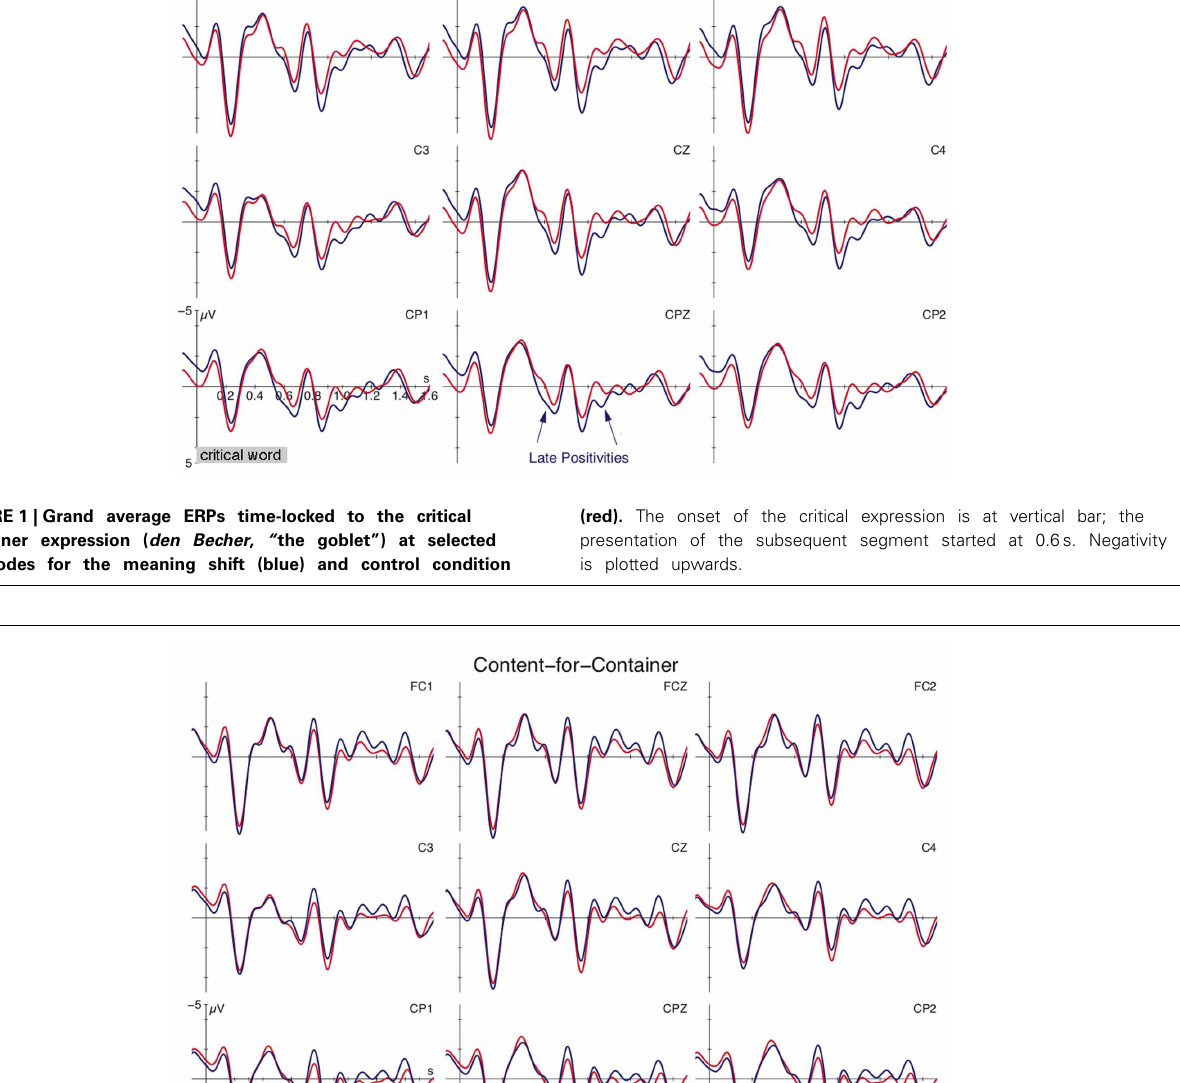
FIGURE 2 | Grand average ERPs time-locked to the critical content expression ( den Zaubertrank, “ the magic potion”) at selected electrodes for the meaning shift (blue) and control condition (red). Time ranges from 100ms before till 1600ms after the onset of the critical expression (onset at vertical bar).